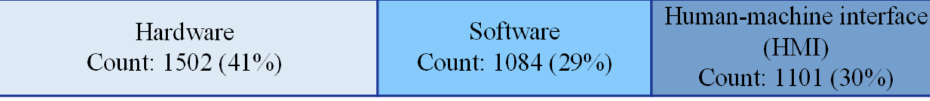
Figure 17. Failure data classification using machine